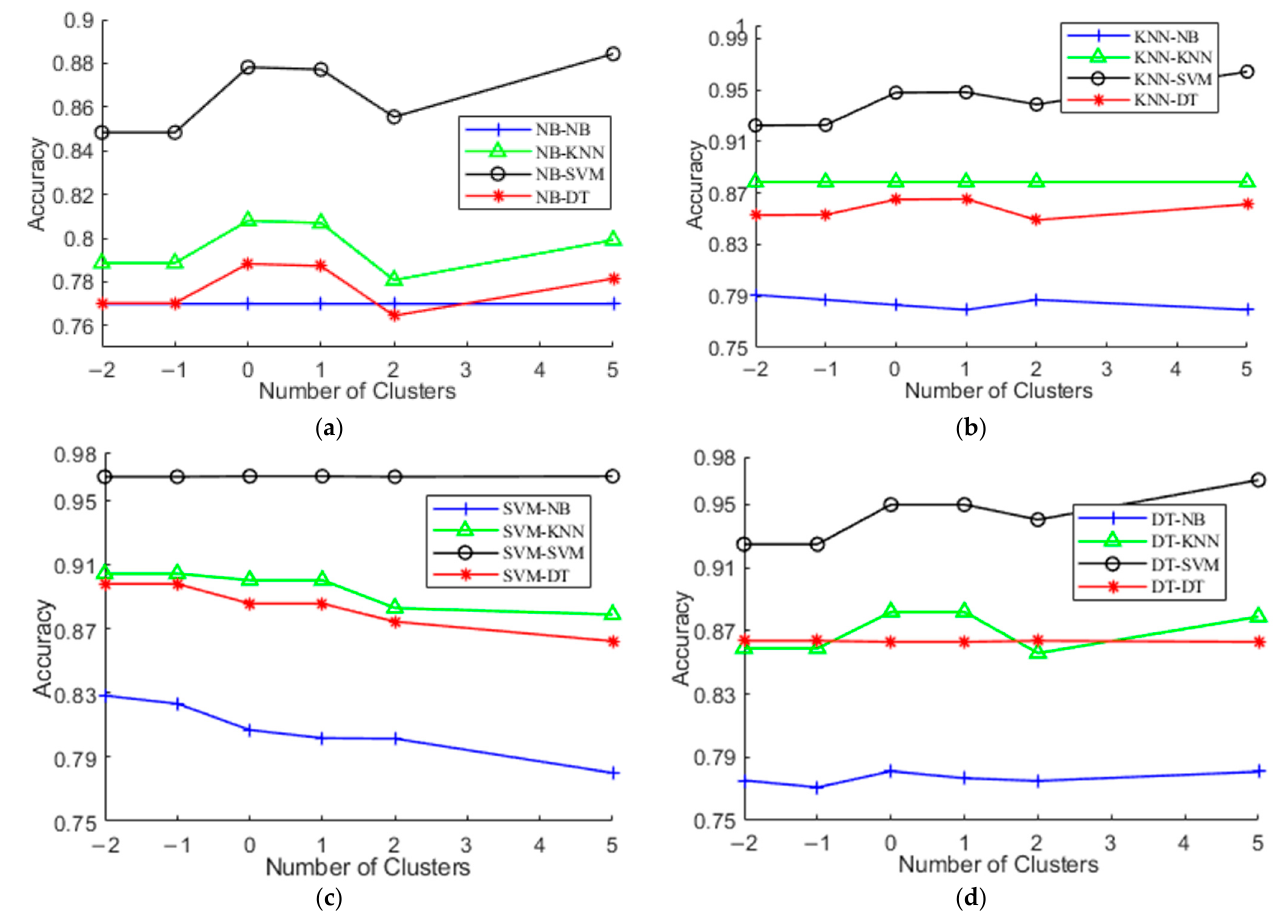
Figure 6. Recognition accuracy vs. different number of clusters. ( a ) NB; ( b ) KNN; ( c ) SVM; ( d ) DT.